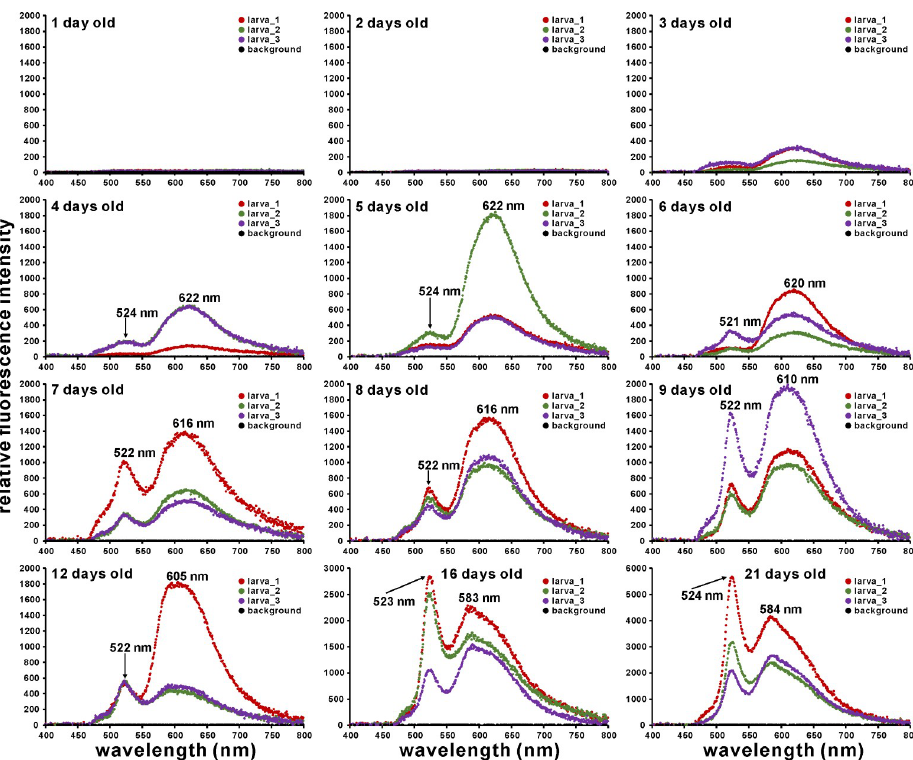
Fig 4. Fluorescence spectrum of A . tenuis larvae under blue-violet excitation (Ex. 400–440 nm, Em. � 475 nm). Peak wavelength at which the maximum intensity was recorded is shown in each graph. Fluorescence intensity in one- day-old and two-day-old larvae was almost at the same level as in the background. The y-axis values for the 16- and 21-day-old larvae are different from the others.